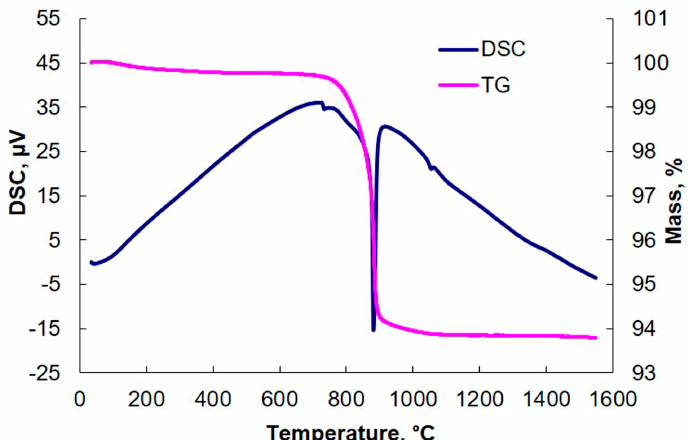
Figure 7. Results of differential scanning calorimetry (DSC) studies of the «tungsten + nanodiamonds» composite sample.